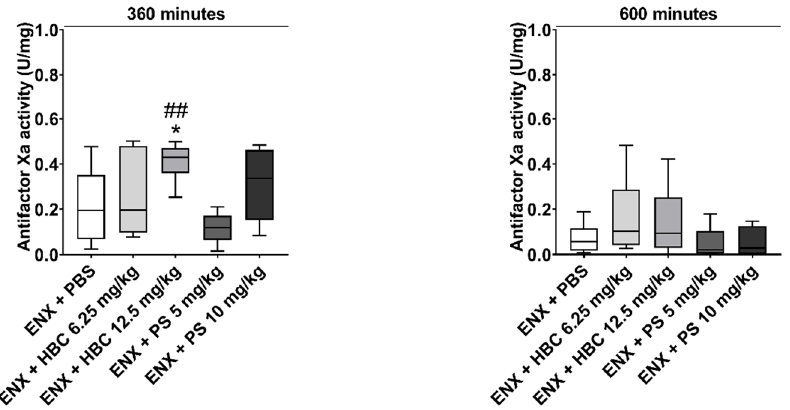
Figure 1. The time-course of the neutralization of enoxaparin (ENX) by HBC (6.25 and 12.5 mg/kg) or protamine sulfate (PS) (5 and 10 mg/kg) in mice, measured by antifactor Xa activity 3, 10, 60, 120, 360, and 600 min after antidote administration. * p < 0.05, ** p < 0.01 vs. ENX + PBS (phosphate buffered saline), # p < 0.05, ## p < 0.01 vs. PS 5 mg/kg, ˆ p < 0.05, ˆˆ p < 0.01 vs. PS 10 mg/kg, Mann–Whitney test. Results are shown as median with lower and upper limits, n = 6.